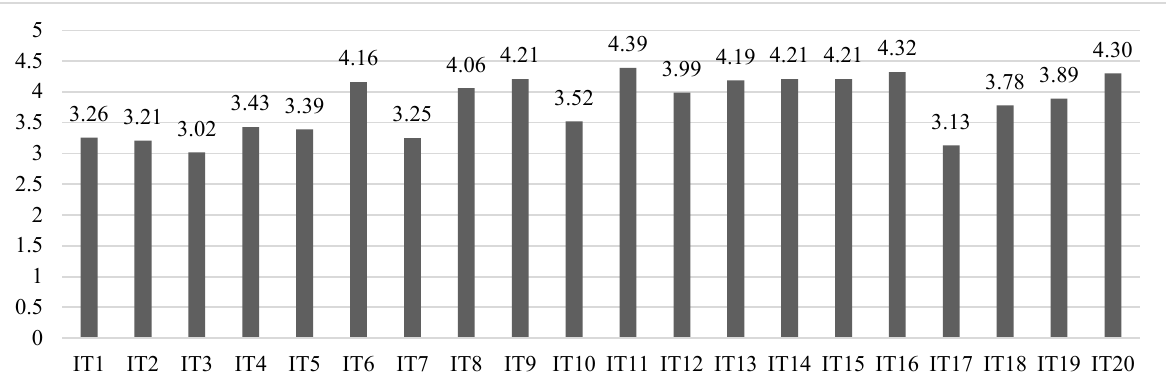
IT1 IT2 IT3 IT4 IT5 IT6 IT7 IT8 IT9 IT10 IT11 IT12 IT13 IT14 IT15 IT16 IT17 IT18 IT19 IT20 Figure 2. Mean scores for each item in the patient advocacy group questionnaire. The highest mean scores were in items 11 (M = 4.39, SD = 0.75), 16 (M = 4.32, SD = 0.97), and 20 (M = 4.30, SD = 0.95). The associations do publicize their rare diseases in schools, emphasizing the characteristics and warning signs, and demonstrate to encourage research in order to achieve more effective and better targeted (as well as more widely available and cheaper) pharmacological treatments and interventions [39,40]. In contrast, the lowest scores were in item 3 (M = 3.02, SD = 1.42), item 17 (M = 3.13, SD = 1.29), and item 2 (M = 3.21, SD = 1.41), resulting from not including the prevalence of existing cases